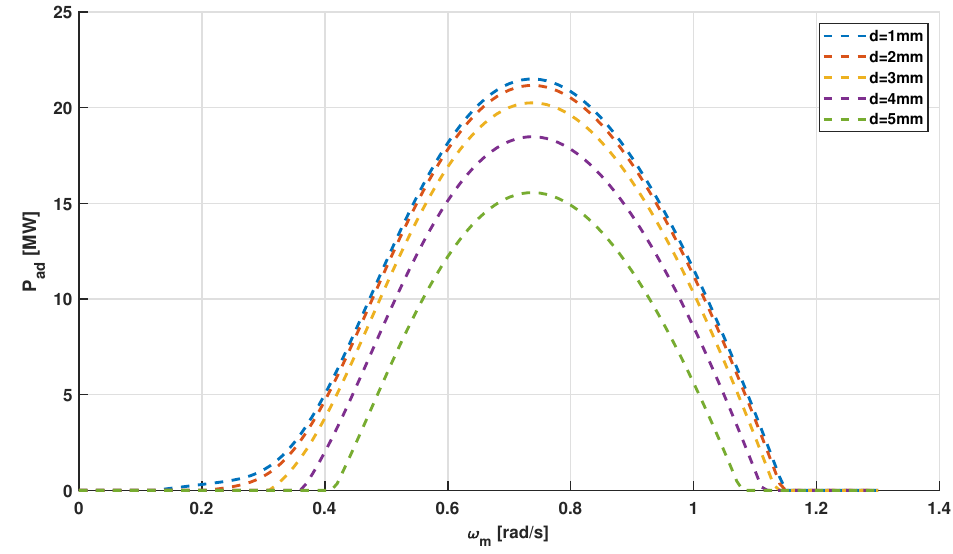
Figure 13. Analytical results of P ad − ω m corresponding to different rain drop diameters d